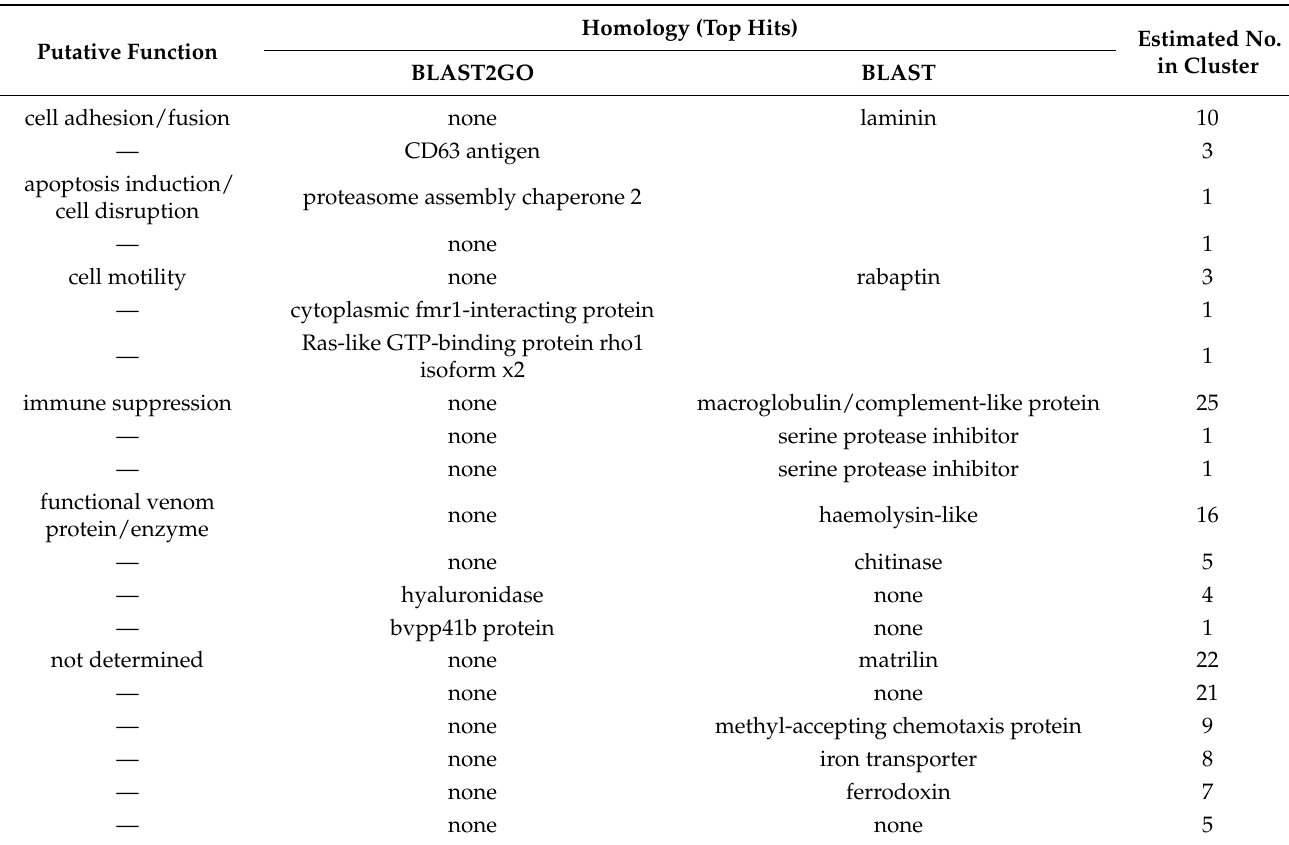
Table 6. Putative functions of selected cDNA gene clusters from venom gland (VG) filaments of Meteorus pulchricornis (Source: based on